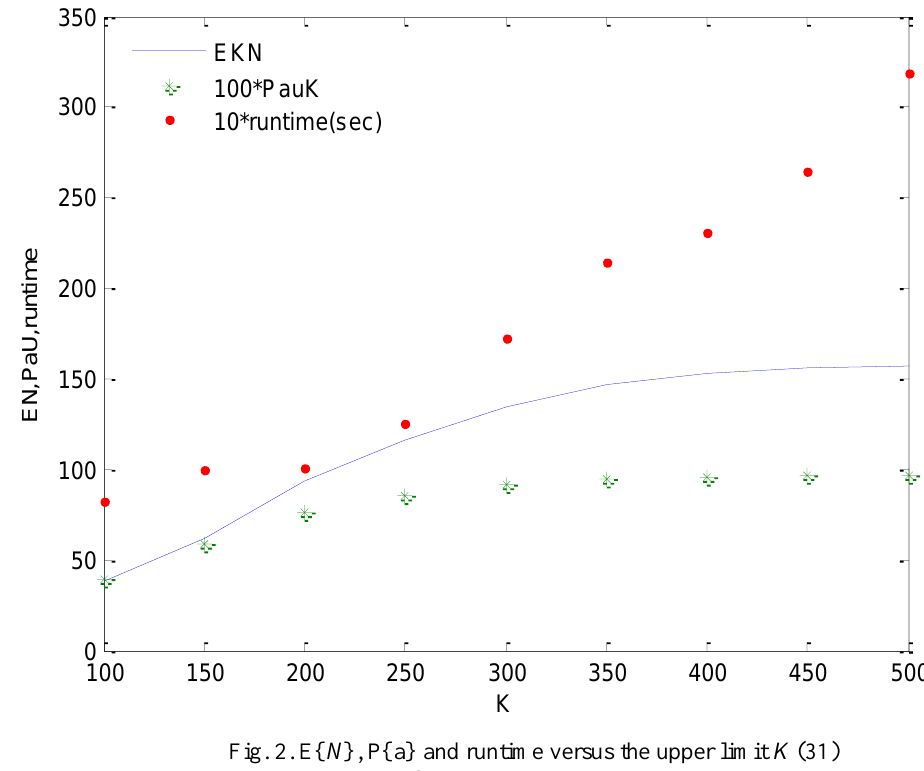
Fig. 2. E{ N }, P{a} and runtime versus the upper limit K (31) CSTF , α=β=0.05, p U =0.99, p L